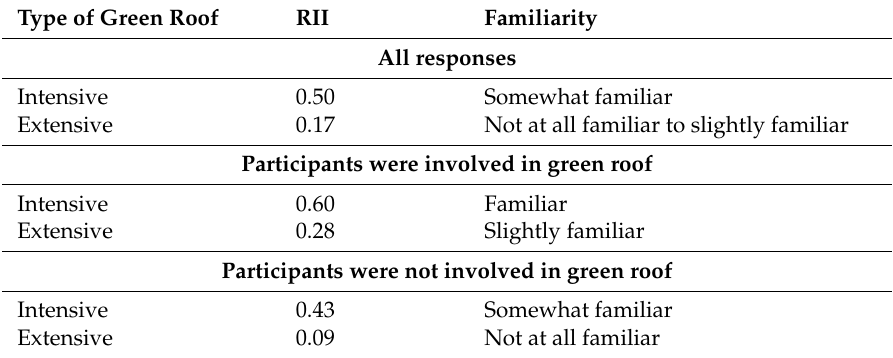
Table 3. Familiarity with green